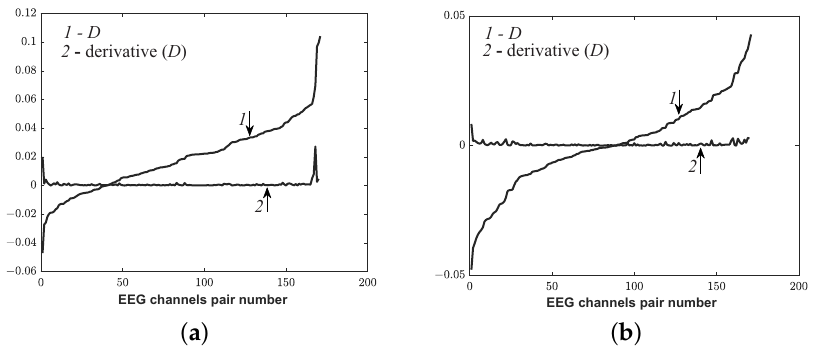
Figure 20. The dependence of D sorted in increasing order (line 1) versus the numbers of a pair of EEG channels and its derivative (line 2) for a patient with TBI in the CT1 test. ( a ) before the rehabilitation; ( b ) after the